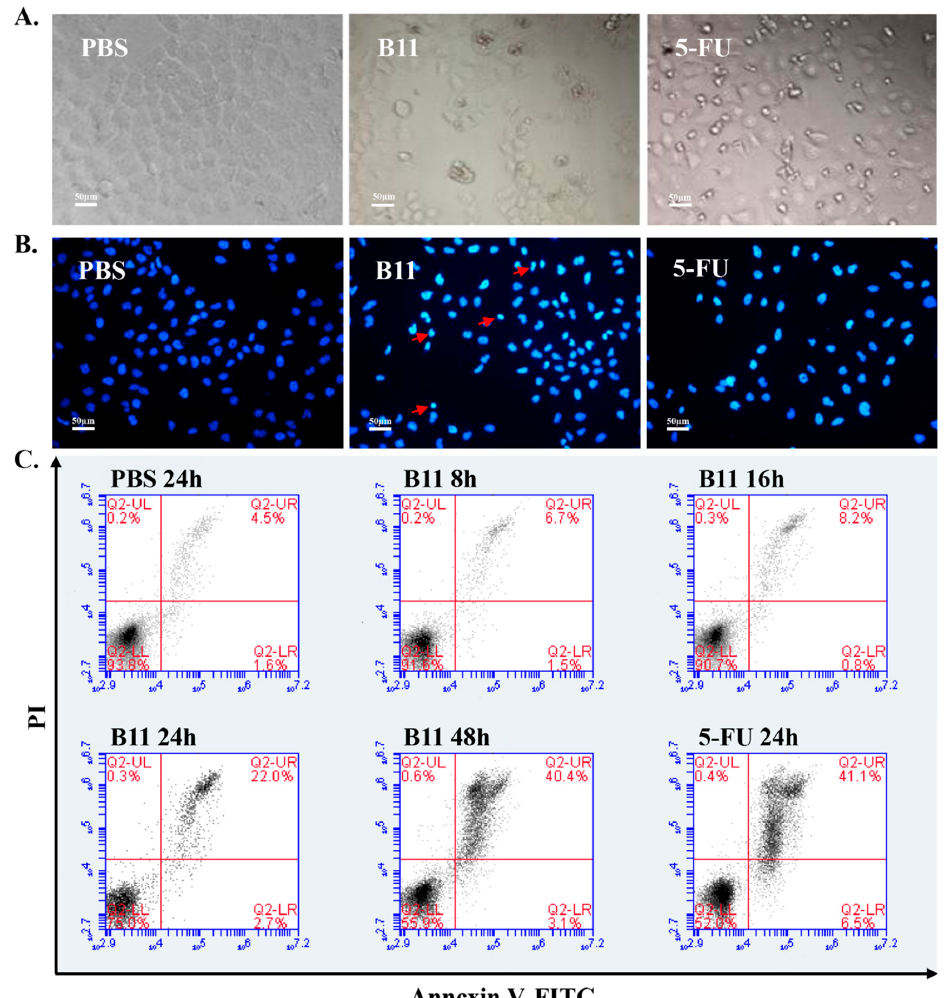
Figure 3. Peptide B11 affects the cell morphology and induces the apoptosis of HeLa cells. ( A ) Changes in cell morphology following treatment with PBS, peptide B11, and 5-FU for 24 h. Micrographs were obtained using an inverted microscope (20×). ( B ) Changes in cell nuclei morphology following treatment with PBS, peptide B11, and 5-FC for 24 h. The 4,6-diamidino-2-phenylindole dihydrochloride (DAPI) stained nuclei were observed with a fluorescence microscope (20 × ). ( C ) Flow cytometric analysis of apoptosis in HeLa cells after 8 h to 48 h of treatment with PBS, peptide B11, and 5-FU, and staining with Annexin V/propidium iodide (Annexin V/PI). Quadrants: lower-left represent live cells (Annexin V negative/PI negative); lower-right represent early apoptotic/primary apoptotic cells (Annexin V positive/PI negative); upper-right represent late apoptotic/secondary apoptotic cells (Annexin V positive/PI positive); upper-left represent necrotic cells (Annexin V negative/PI positive). The numbers in the respective quadrants indicate the percentage of cells present in that area. Data shown represent one of three independent